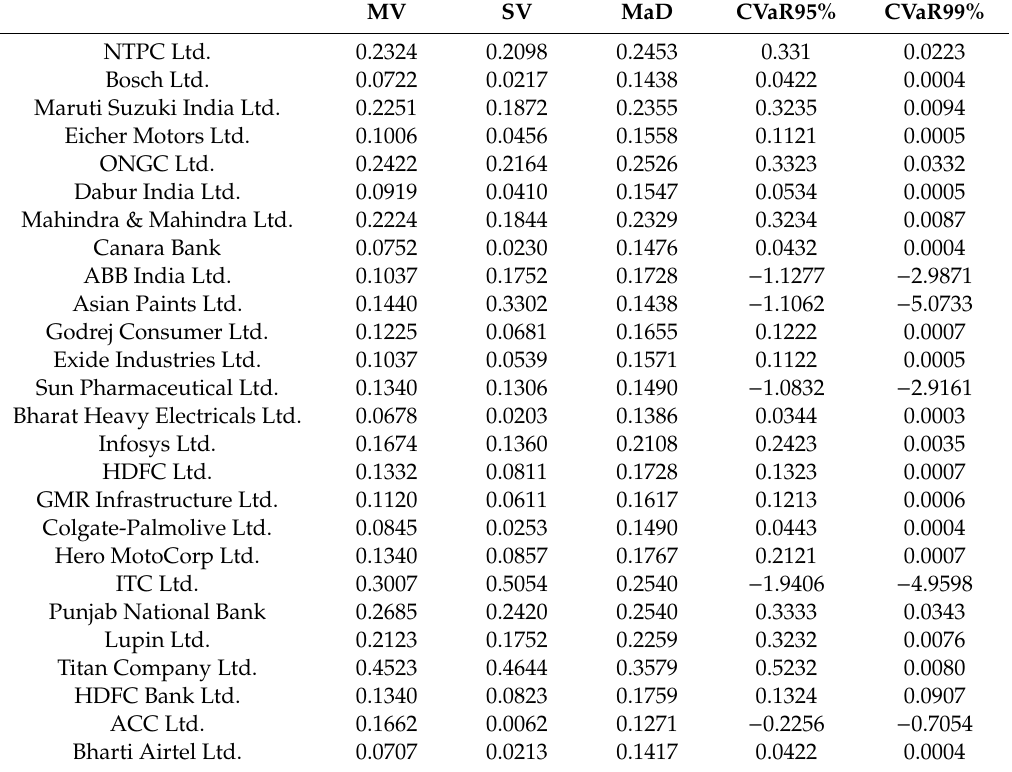
Table 7. Optimal portfolio compositions for economic crisis period (2004–2007).